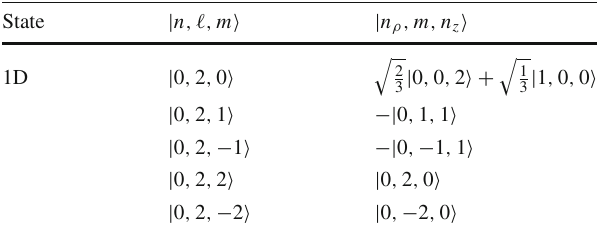
Table 11 The transformation of the 1D wave (states with n = 0 and (cid:16) = 2) from the spherical coordinate to the cylindrical